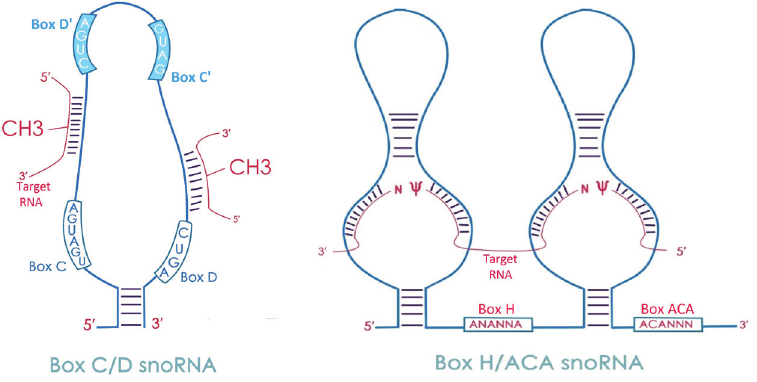
Figure 3 Anatomical features of C/D and H/ACA snoRNAs. (A) The secondary structure of the C/D snoRNA box entails conserved sequences (box C and box D) that base pair with target RNA. (B) H/ACA snoRNAs are formed of two hairpin units separated by a single-stranded hinge that contains box H. Each hairpin structure is formed of a lower stem, pseudouridylation pocket, upper stem and an apical loop. Target RNA is contained within the pseudouridylation